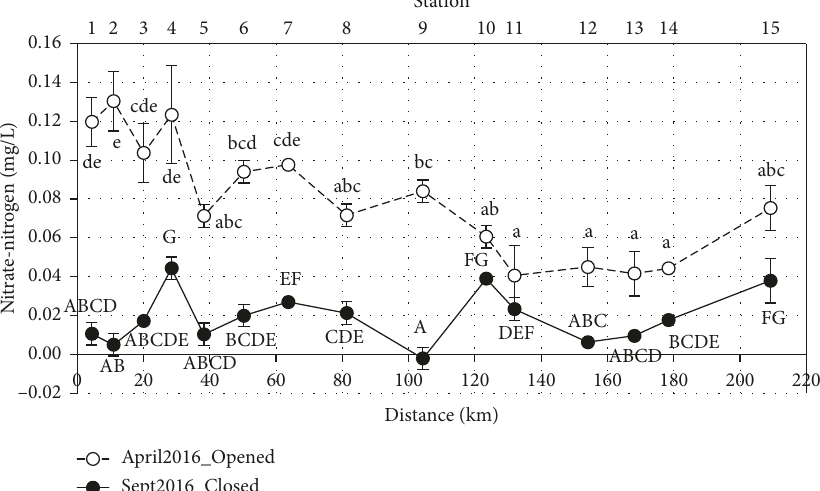
Figure 10: Nitrate-nitrogen at the 15 stations downstream of Bakun Hydroelectric Dam during opened spillway ( o ) and closed spillway ( • ). The same letter indicates no significant difference ( p > 0 .